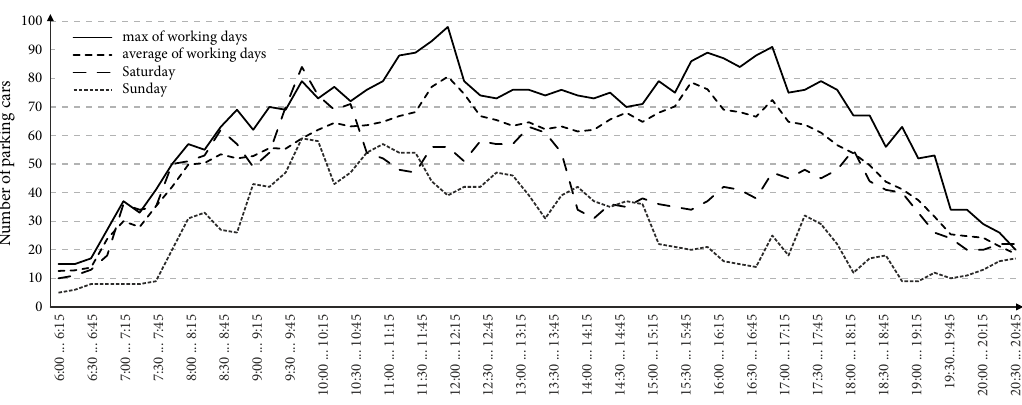
Figure 2. Intensity of arriving and departing cars during hours of weekdays